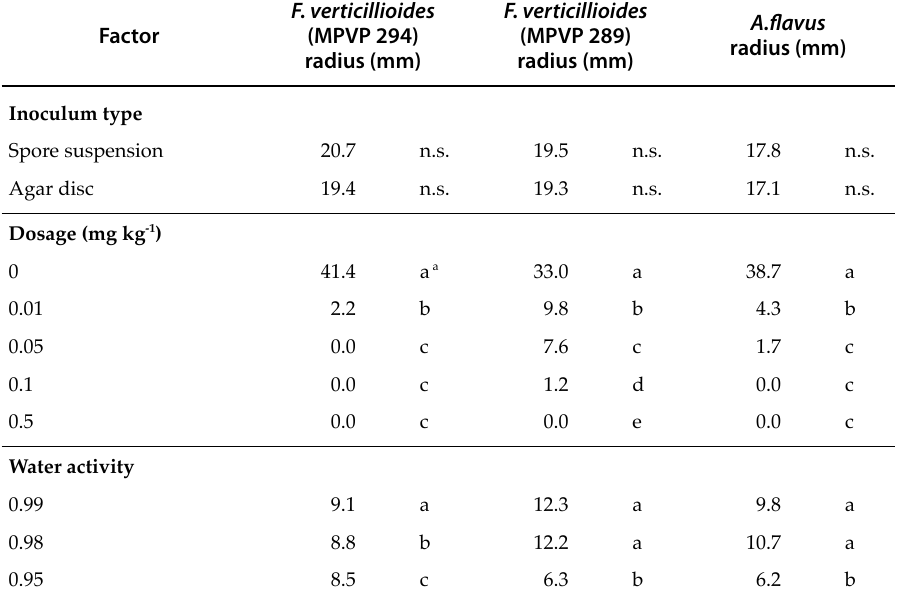
Table 2. Results of ANOVA regarding the effect of inoculation method, the fungicide Sportak 45EW ® , and water activity (0.99, 0.98 and 0.95) on in vitro growth of Fusarium verticillioides (MPVP 294 and MPVP 289) and Aspergillus flavus incubated at 25°C for 14 days, measured as colony radius